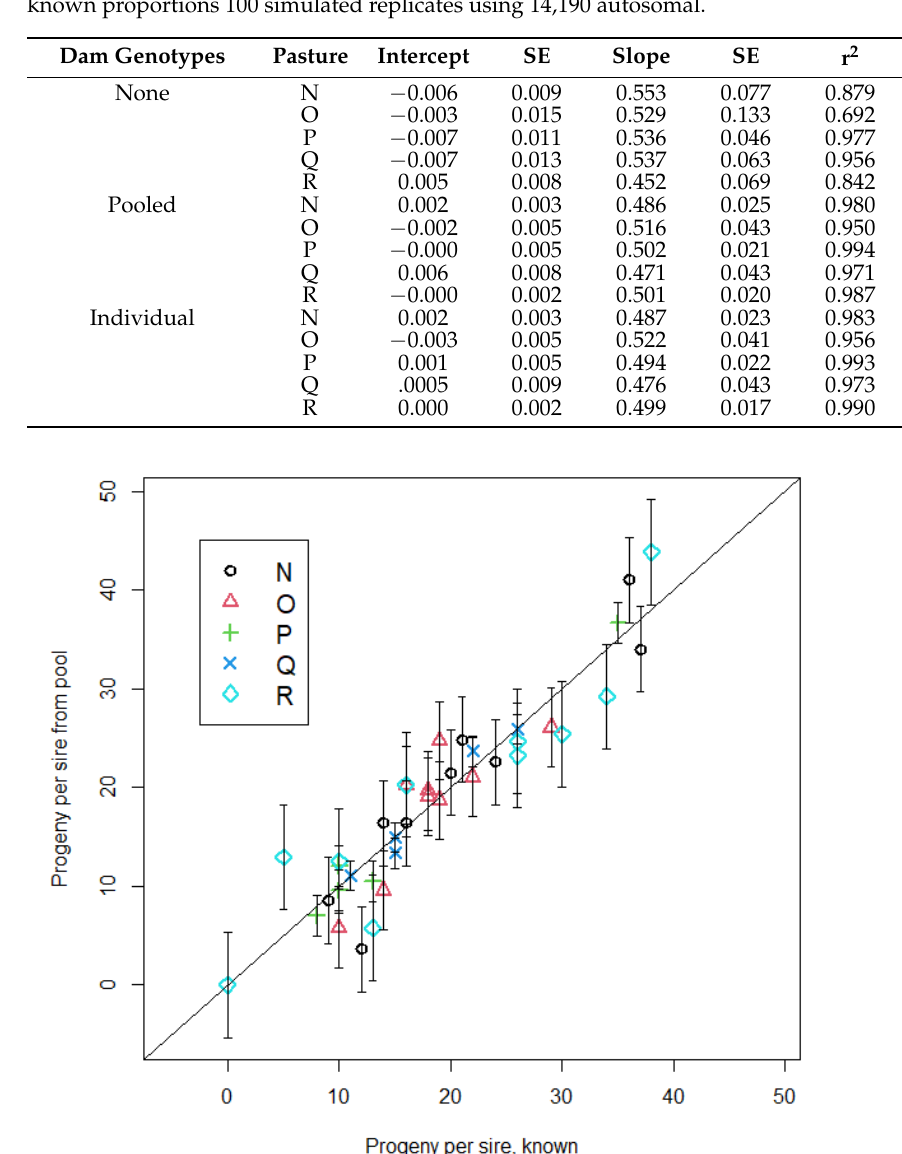
Figure 1. Pooling estimates of sire progeny numbers for 2016 calf crop by known progeny numbers using 14,190 SNP. Dam allele frequencies were assumed unknown for this graph. Error bars are lack of fit SD between pooling sire progeny number and known progeny number. Symbols in the legend identify different pastures.